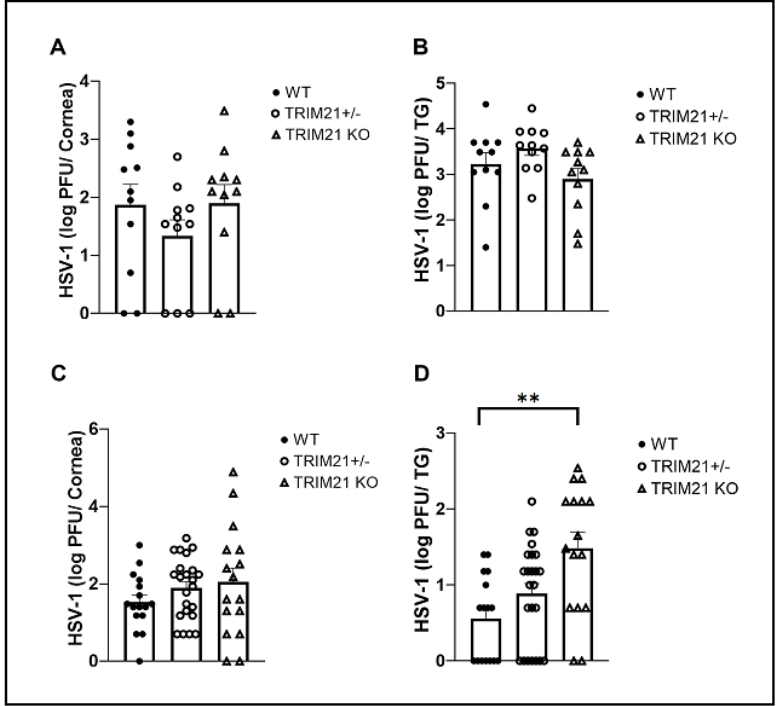
Figure 2. HSV-1 levels are elevated in the trigeminal ganglia of TRIM21 KO mice at day 7 post infection. Male and female C57BL/6 (WT), TRIM21+/ − , and TRIM21 KO mice (n = 11–22/group) were infected with HSV-1 (10 3 PFU/cornea). At day 3 ( A , B ) or day 7 ( C , D ), the corneas ( A , C ) and trigeminal ganglia (TG) ( B , D ) of infected mice were removed and processed to determine viral load/tissue by standard plaque assay. Bars represent mean + SEM, ** p < 0.01 comparing the TRIM21 KO to WT mice day 7 pi, as determined by one-way ANOVA and Kruskal–Wallis multiple comparison test.